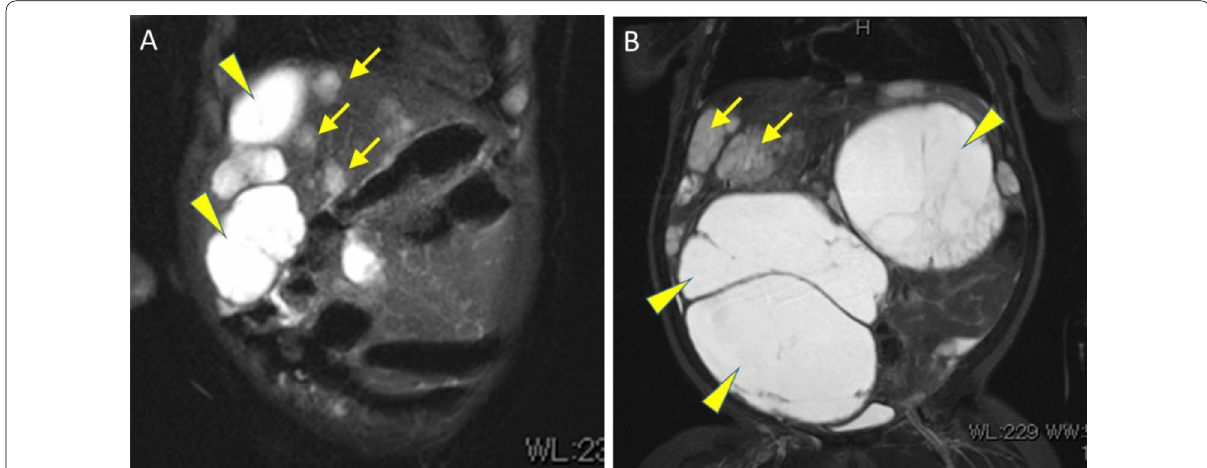
Fig. 2 Coronal T2-weighted MR image at 2 months ( A ) and at 9 months ( B ). Both cystic (arrowheads) and solid (arrows) components show rapid increases after 7